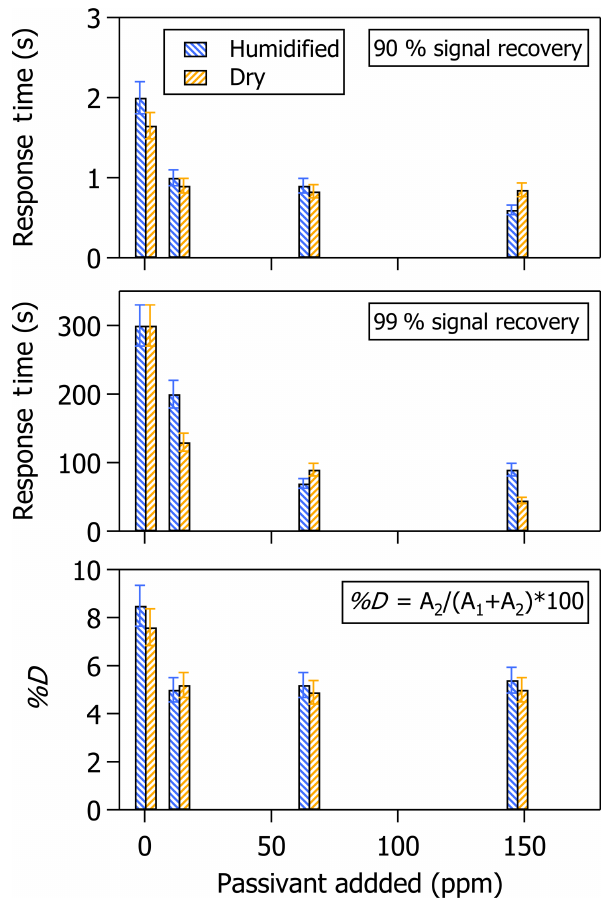
Figure 7. Response times ( t 90 and t 99 ) and % D associated with increasing C 8 passivant addition for a step change in NH 3 mixing ratio generated on top of a dry versus humidified